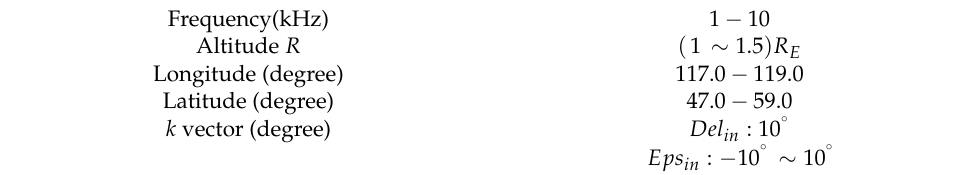
Table 1. Initial conditions of ray path for the first event.